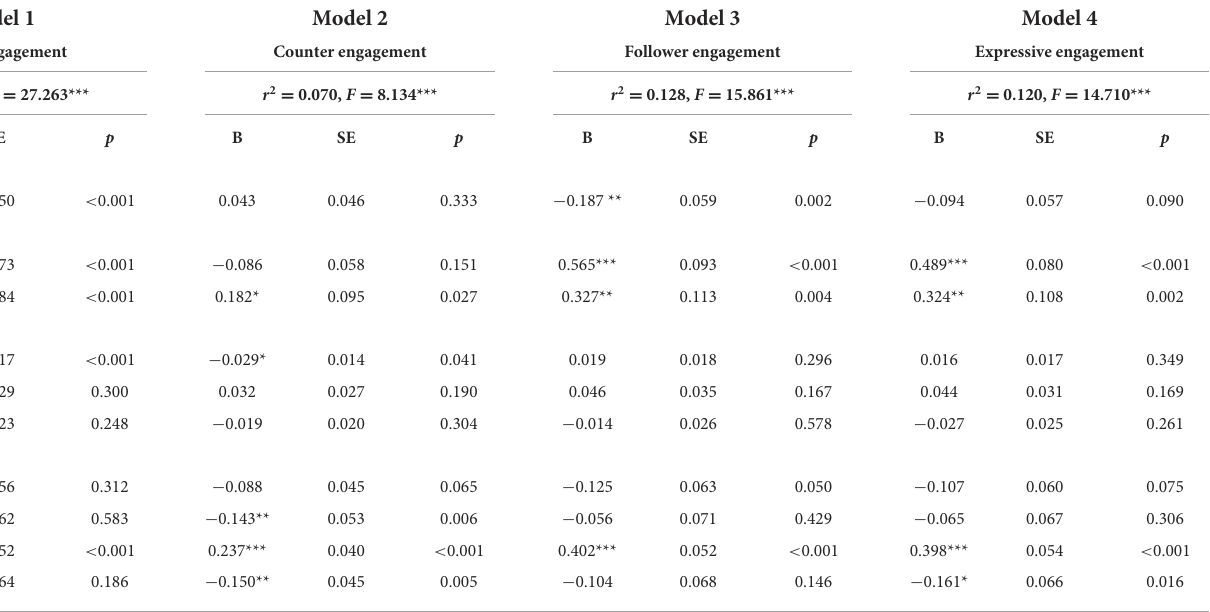
TABLE 2 Multiple regression tests for predictors of SMPP-GI ( N =